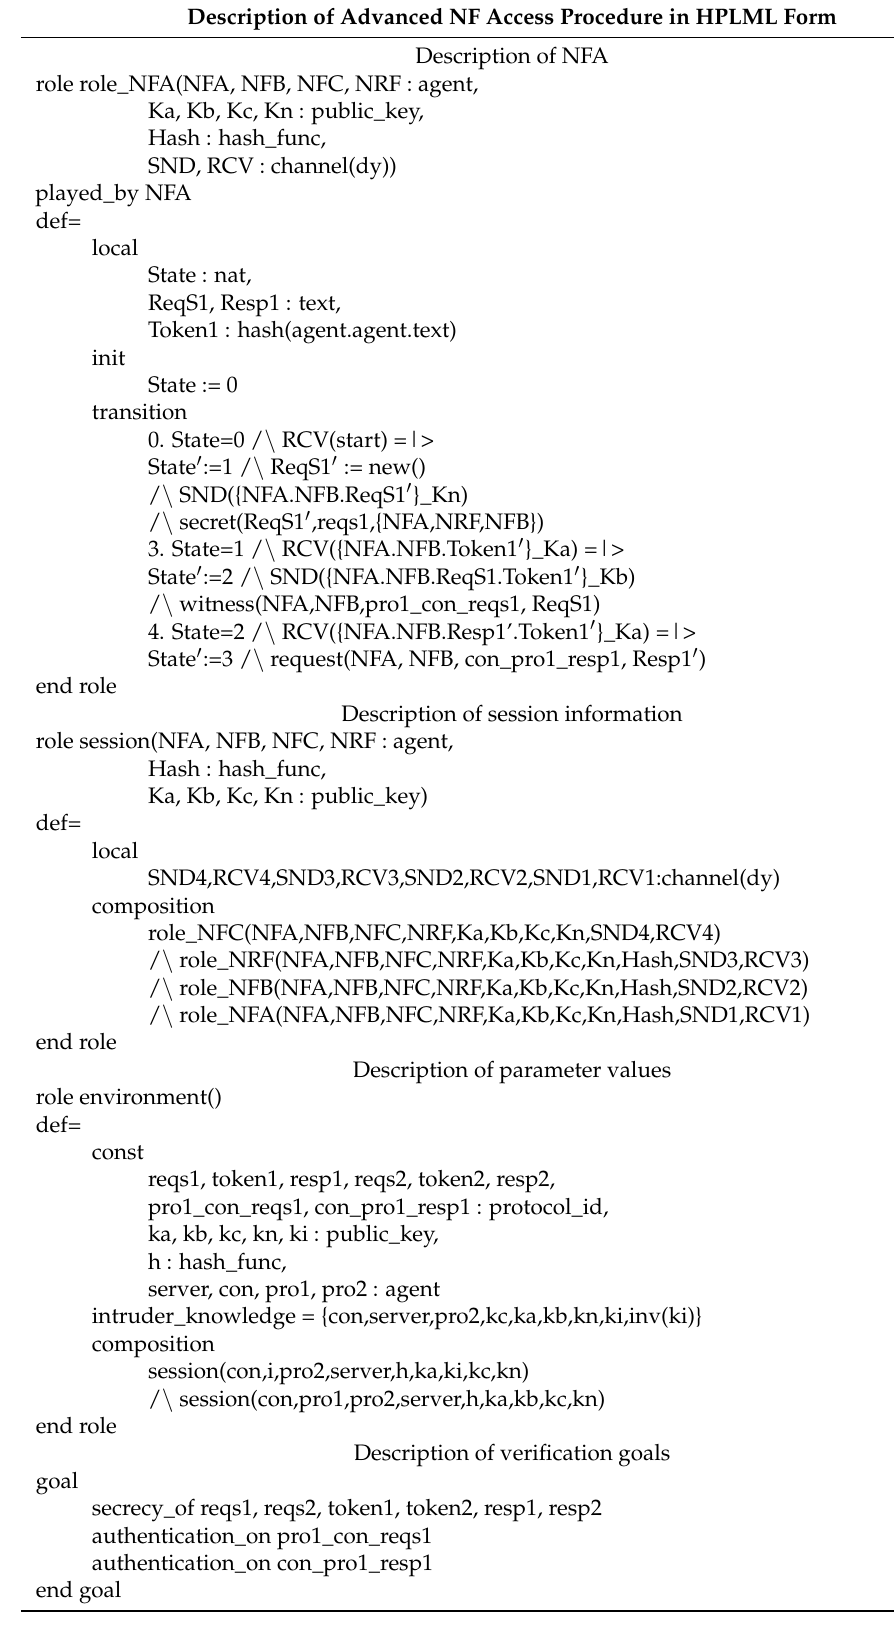
Table 10. Description of Advanced NF Access Procedure in HPLML